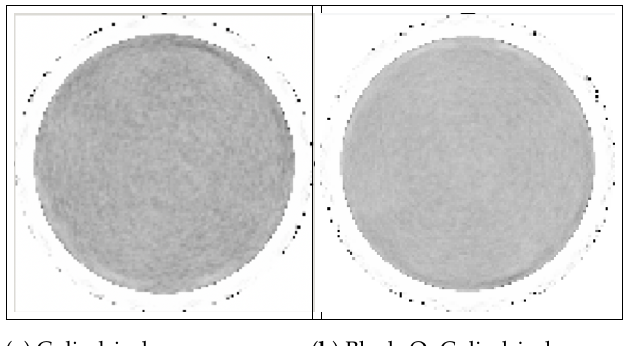
Figure 10. Reconstruction of the uniform cylinder using the “Cylindrical” class ( a ) and the “Block- sOnCylindrical” class ( b